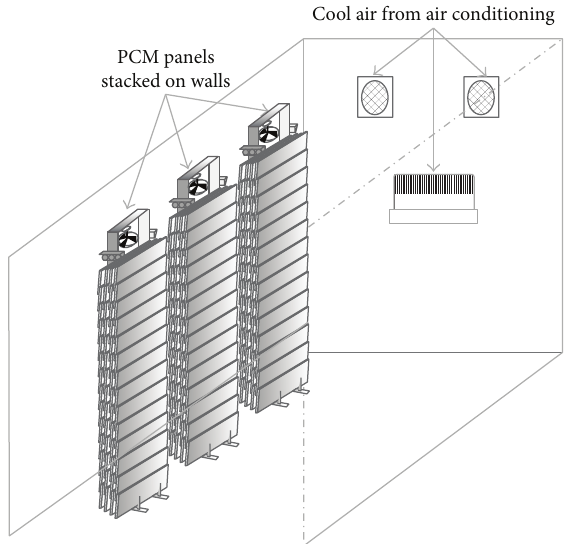
PCM panels stacked on walls